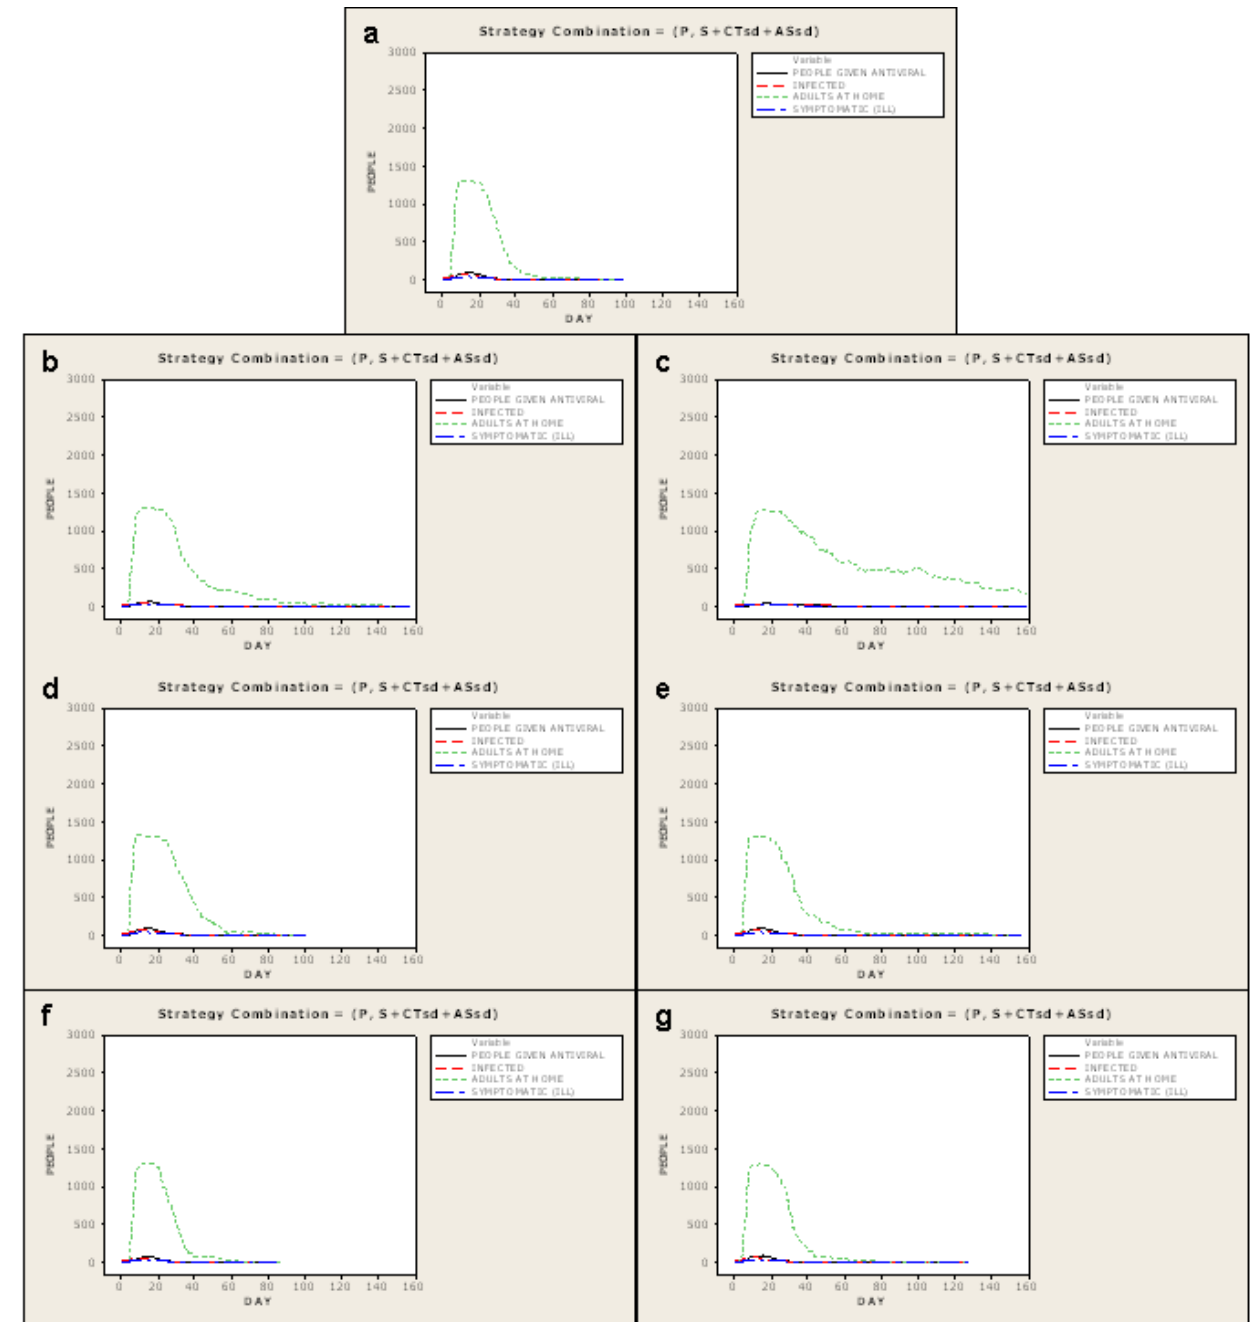
Figure 6. Epidemic effects with extended parameter assumptions. Plots of I F 1.5 epidemics (Ferguson-like disease manifestation, at 90% compliance, with regional mitigation) showing extensions of parameter assumptions. Plots are averages of all 100 simulations. Comparisons are to the best strategy plot. a—the best strategy found in these simulations (P + S + CTsd + ASsd). b—best strategy under Longini-like assumptions of influenza natural history. Note the similar peak in numbers of infected and symptomatic, but there are additional and extended requirements for antiviral use, adult days at home and longer duration of epidemic effects. c—best strategy with Longini-like with extended period of infectiousness. Note the elongated downslope (and overall increase) of required adult days at home and long duration of epidemic effects. d—best strategy with similar transmission across age classes. Note the minimal increase in duration of adult days at home and duration of epidemic effects. e—best strategy with augmented social networks. Note the slight increase in duration of adult days at home and the significantly increased duration of epidemic effects. f—best strategy with pre-pandemic vaccine targeted to children and teenagers. Note the similarity in curves of required adult days at home and the slightly decreased duration of epidemic effects (from 100 days to 90 days). g—best strategy and pre-pandemic vaccine targeted to adults. Note the lack of benefit on numbers of infected, symptomatic, adult days at home and the increased duration of epidemic effects (from 100 days to 130 days).